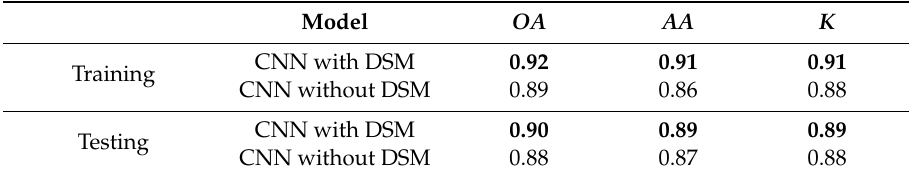
Table 6. Performance of the classification methods used in the current study measured using standard accuracy